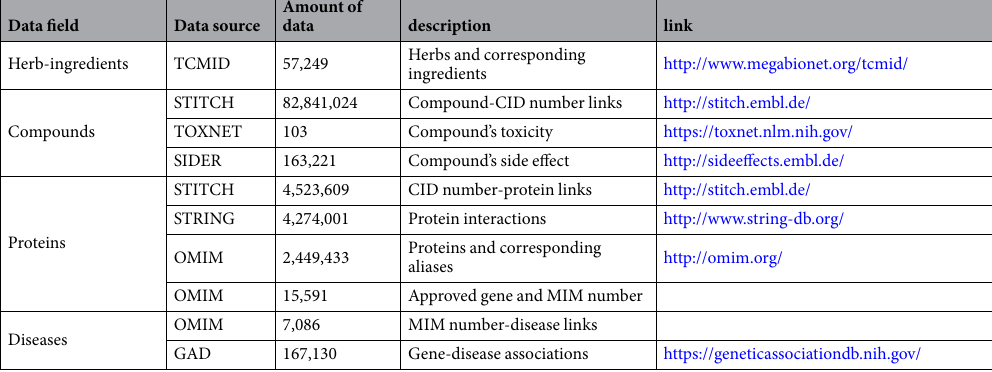
Table 4. Data sources of the TCM-Mesh and detailed information of different databases. The data were mainly divided into four groups: Herb-ingredients links, compounds, proteins and diseases, the totally data were obtained from seven authentic databases: TCMID, STITCH, STRING, OMIM, GAD, TOXNET and SIDER. The size of each database, the description of every database and the website links of all databases were